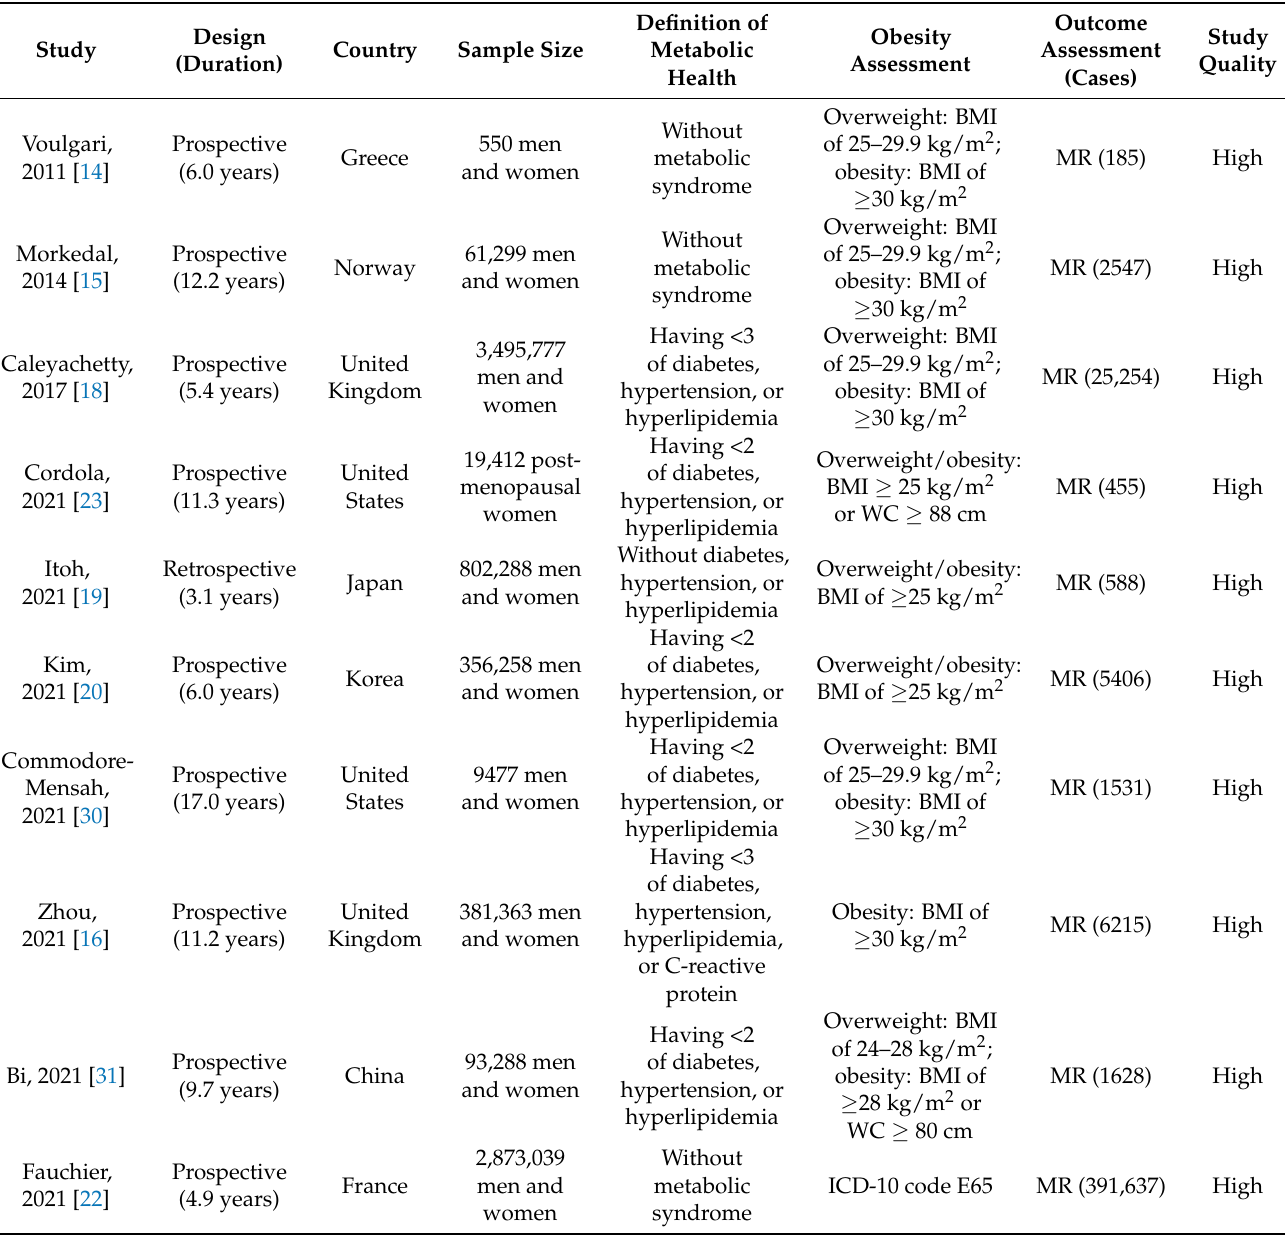
Table 1. Characteristics of studies evaluating the relationships of metabolic health status and obesity status with the risk of heart